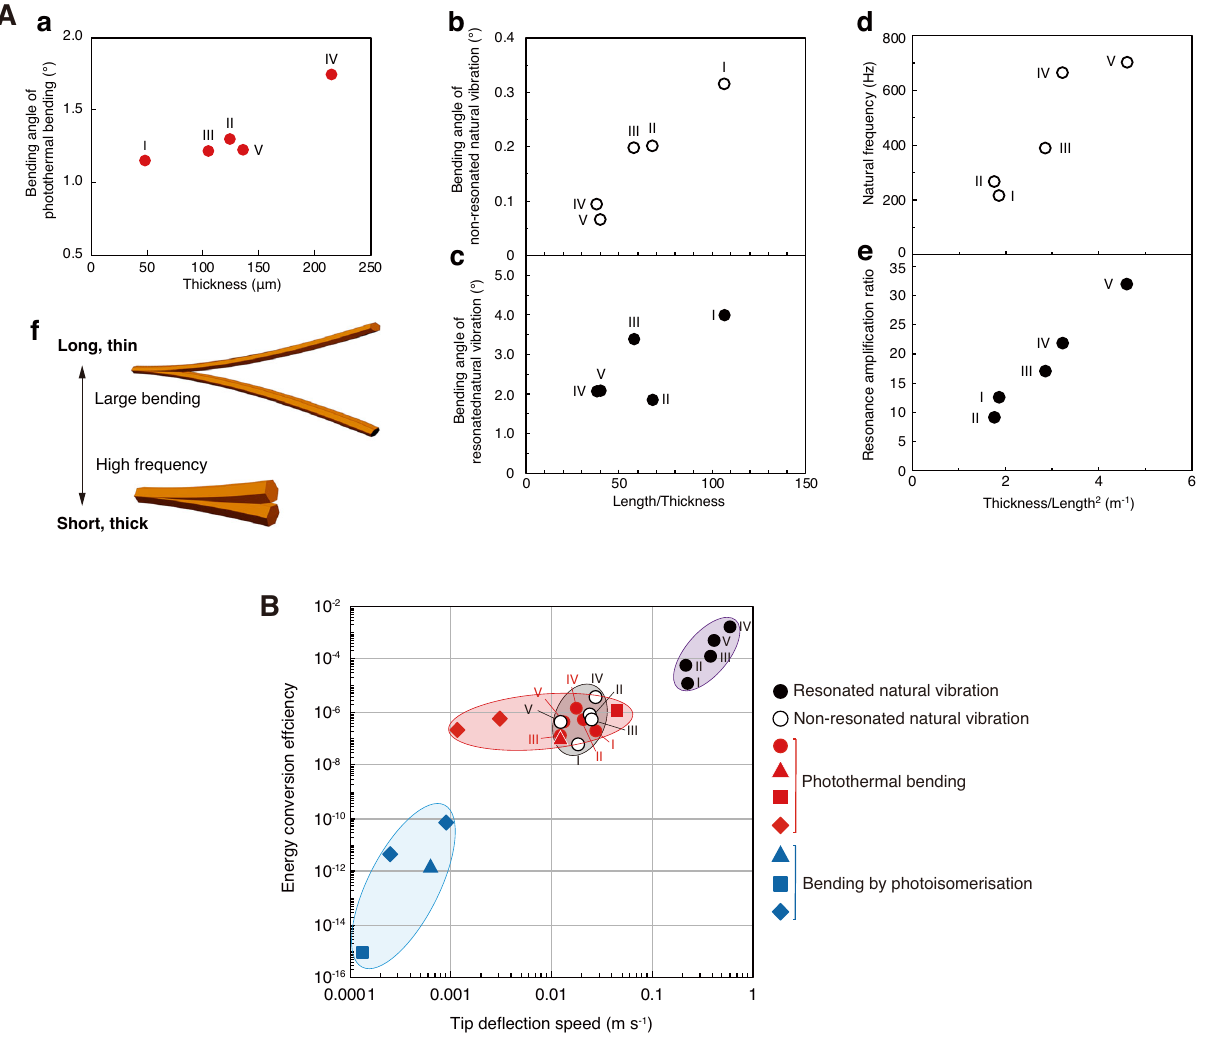
Fig. 4 | Actuation performance. A Relationship between crystal shape and bend- ing behaviour of 1 β crystals I – V. a Thickness dependence of the photothermally driven bending angle. b , c Aspect ratio (length/thickness) dependence of the maximum bending angle of the non-resonated natural vibration ( b ) and the reso- nated natural vibration ( c ). d , e Thickness/length 2 dependence of the natural fre- quency( d )andtheresonanceampli fi cationratio( e ). f Schematicdiagramofcrystal shapestorealiselargebendinganglesandhighfrequencies. B Relationshipbetween